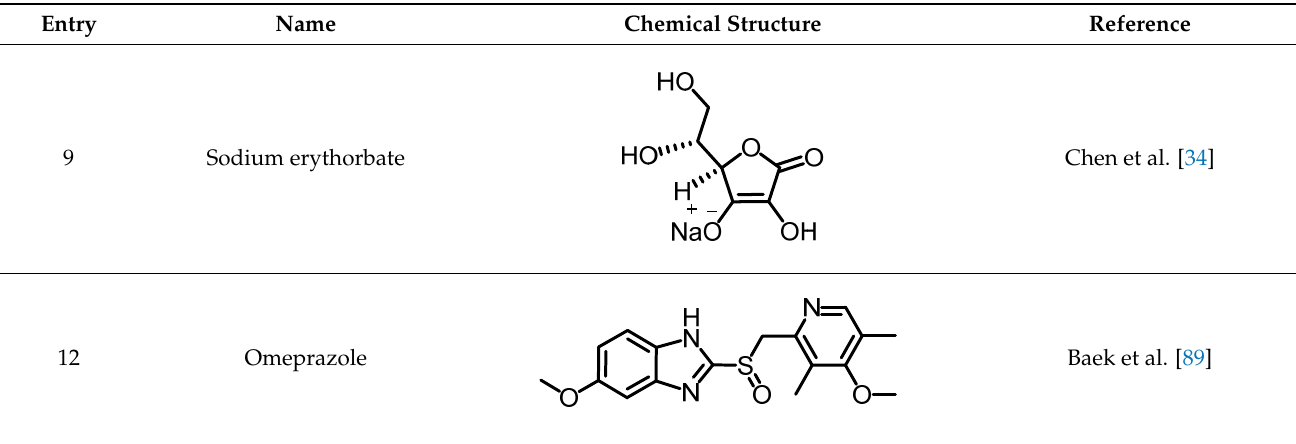
Table 4. Synthetic compounds used as melanogenesis inhibitors in zebrafish embryos.